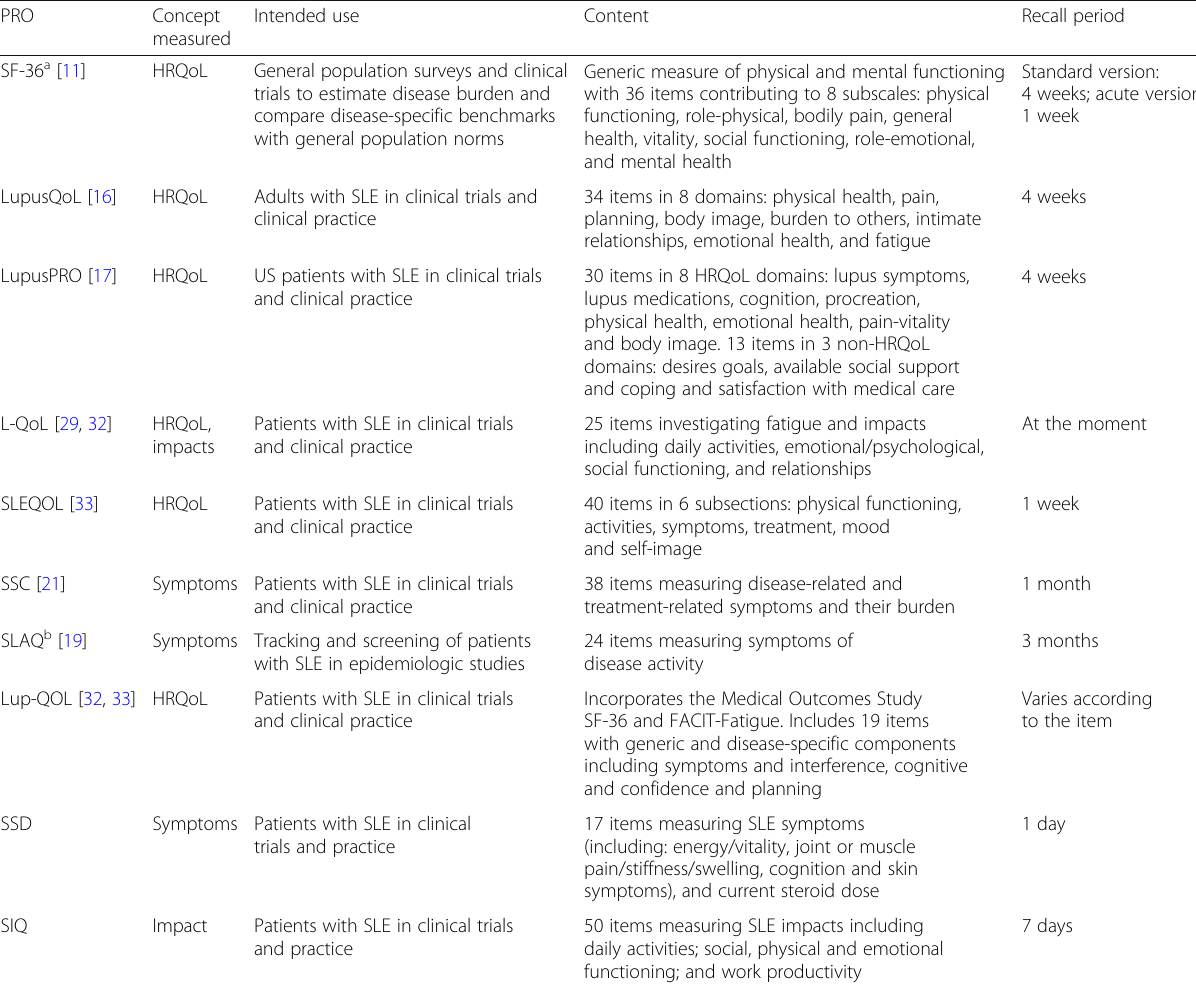
Table 1 Summary of commonly used SLE PROs and characteristics of the SSD and SIQ